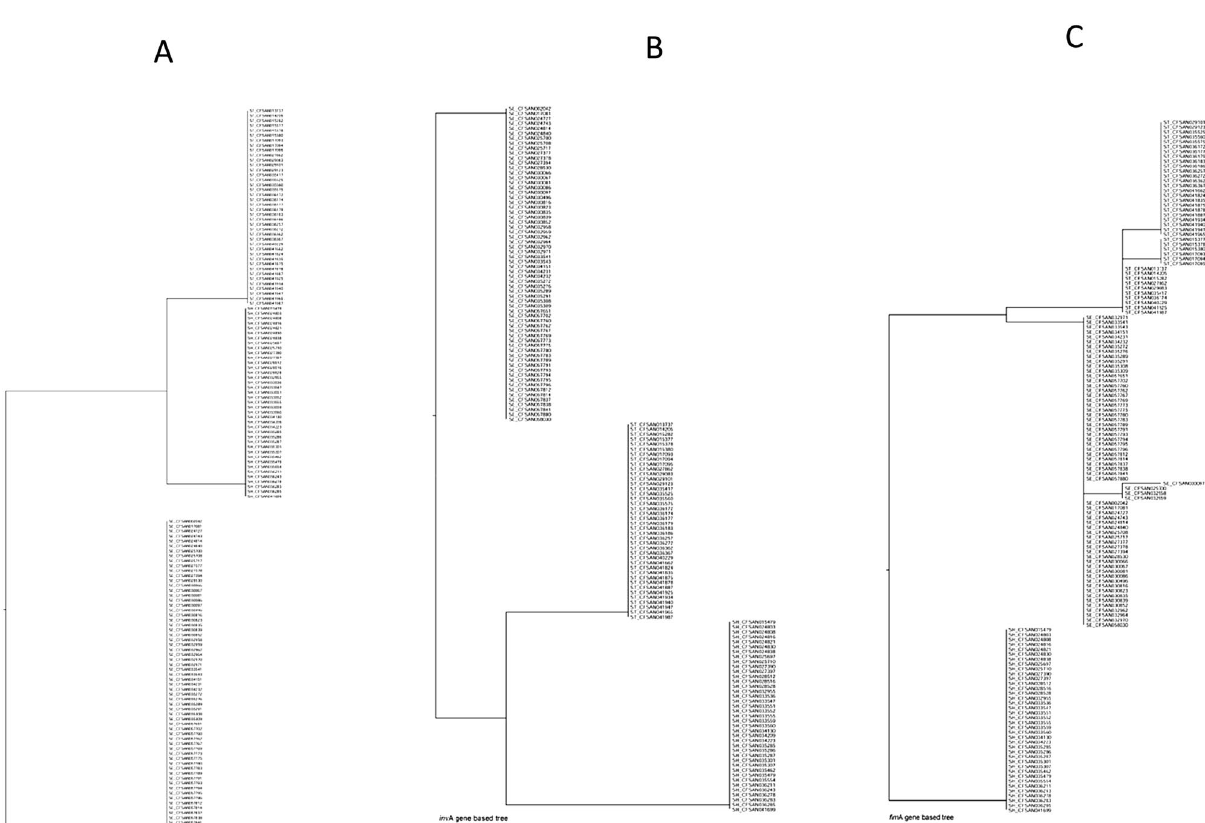
Figure 4. Phylogenetic trees of all sequenced Salmonella isolates based on nucleotide sequences of the target genes agf A ( A ), inv A ( B ), and fim A ( C ). The trees were constructed by the neighbor jointing method using CLC Genomics Workbench. The scale indicates the sequence percentage of base distance (percent